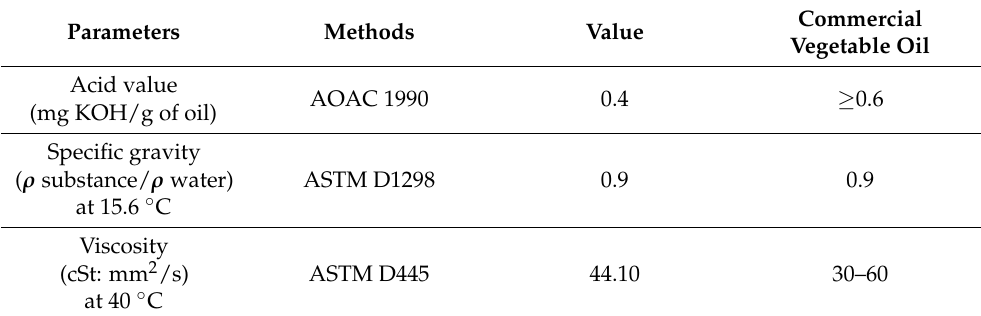
Table 1. Characterisation of RBO.